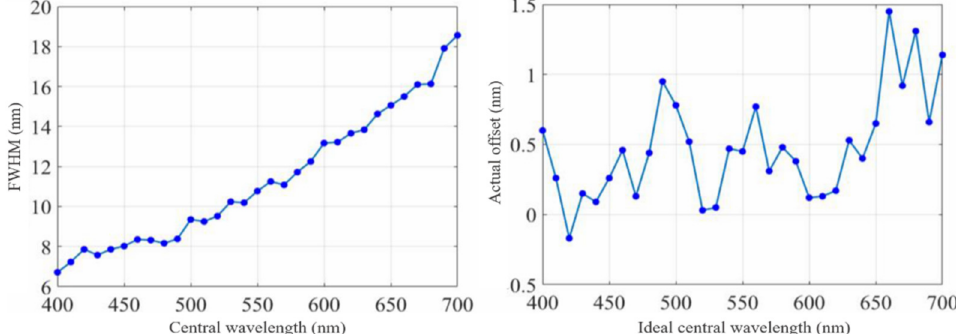
Figure 4. Modulation accuracy of FWHM and central wavelength of response spectrum of USI